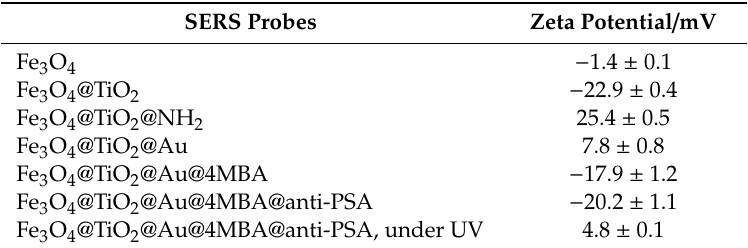
Figure 2. ( a ) EDS spectra of Fe 3 O 4 @TiO 2 @Au nanocomposites. ( b ) XRD patterns; ( c ) UV-vis absorption spectra; and ( d ) magnetization curves of Fe 3 O 4 ; Fe 3 O 4 @TiO 2 ; and Fe 3 O 4 @TiO 2 @Au nanocomposites. Table 1. Zeta potential